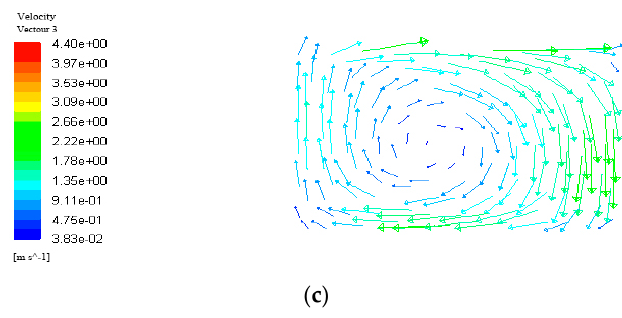
Figure 4. Cross-sectional and longitudinal section pressure distribution and flow velocity vector distribution of fluid in triangular micro-textures: ( a ) cross-sectional pressure distribution; ( b ) longitudinal section pressure distribution; ( c ) longitudinal section speed vector distribution.